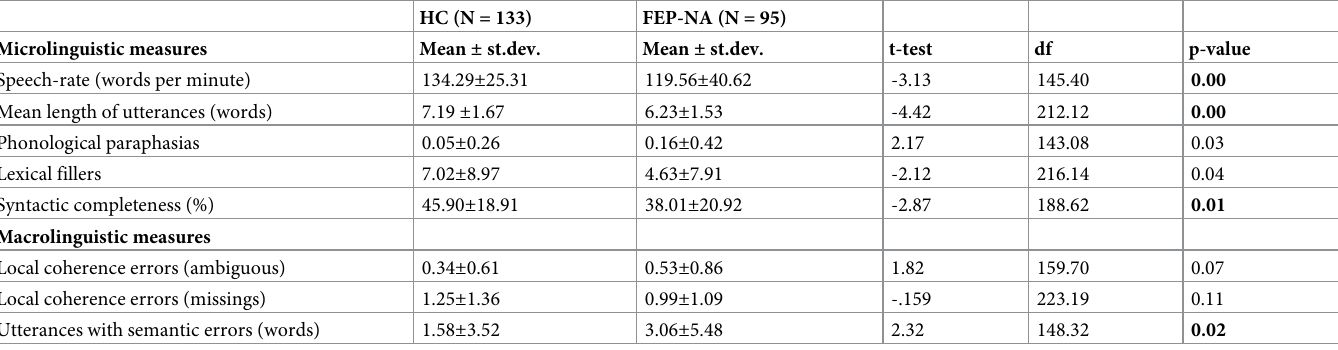
Table 3. Post-Hoc analysis (HC vs FEP-NA).